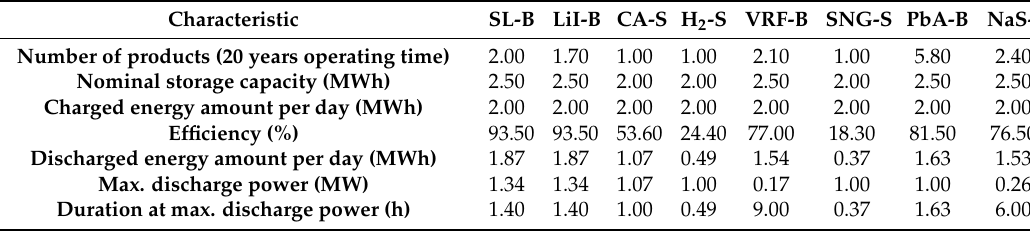
Table 1. Main characteristics of EEST